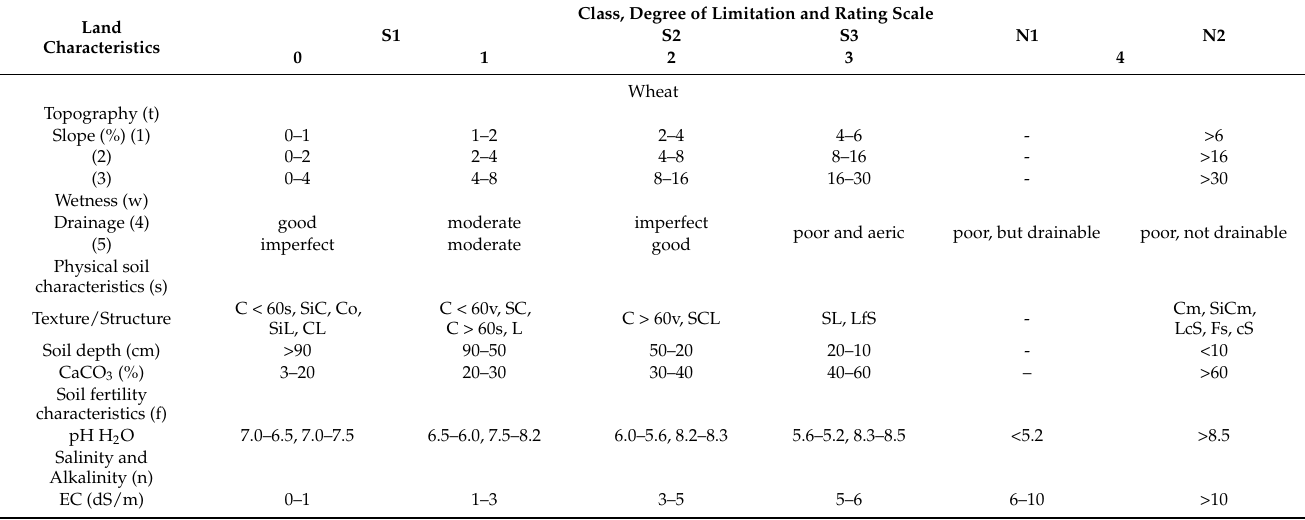
Table 1. Topographic and soil requirements—Wheat, sugarcane, sorghum, and millets